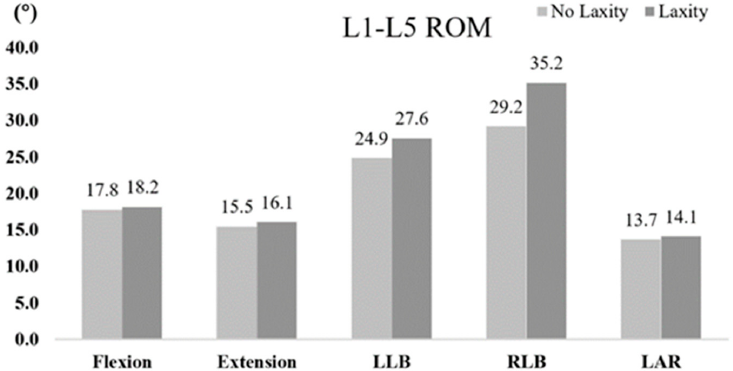
Figure 2. Range of motion of lumbar vertebrae.